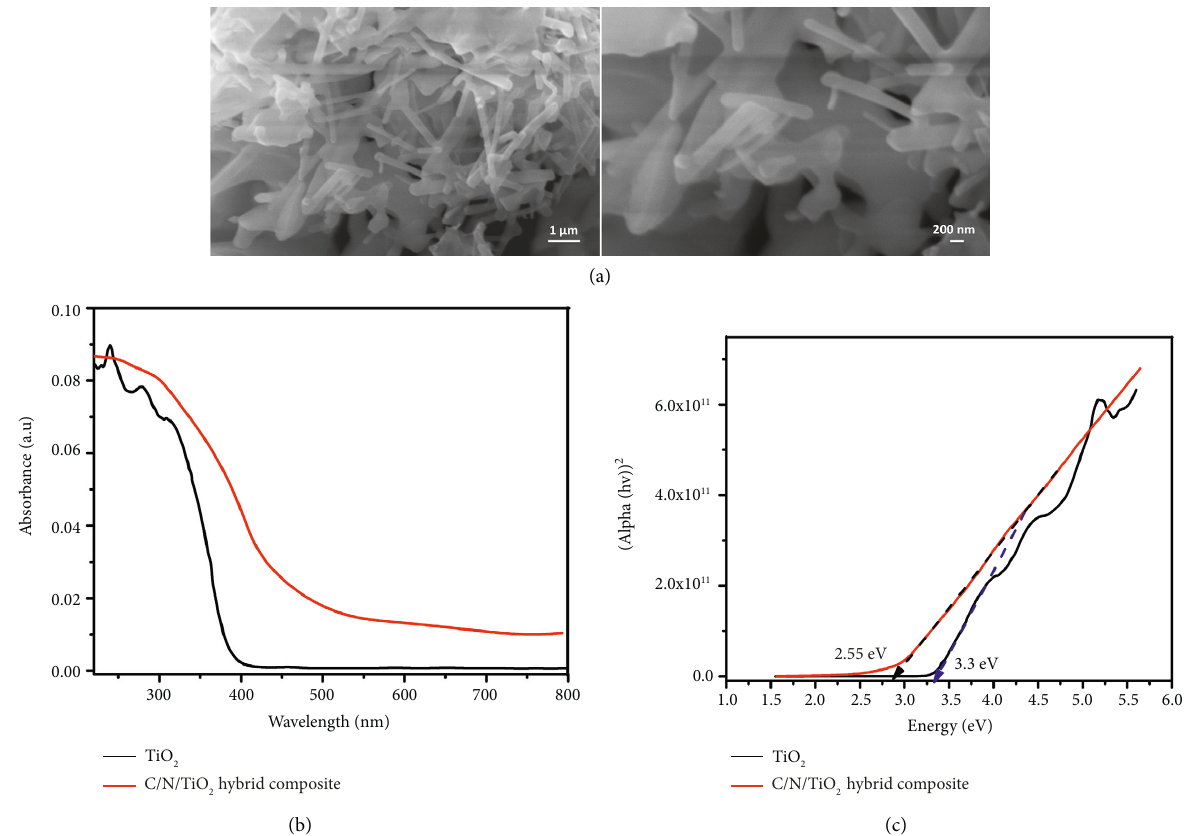
Figure 2: (a) SEM images of bio-inspired C/N/TiO 2 hybrid composite. (b) UV-Vis spectra of pure TiO 2 and bio-inspired C/N/TiO 2 hybrid composite. (c) Tauc plots of pure TiO 2 and bio-inspired C/N/TiO 2 hybrid